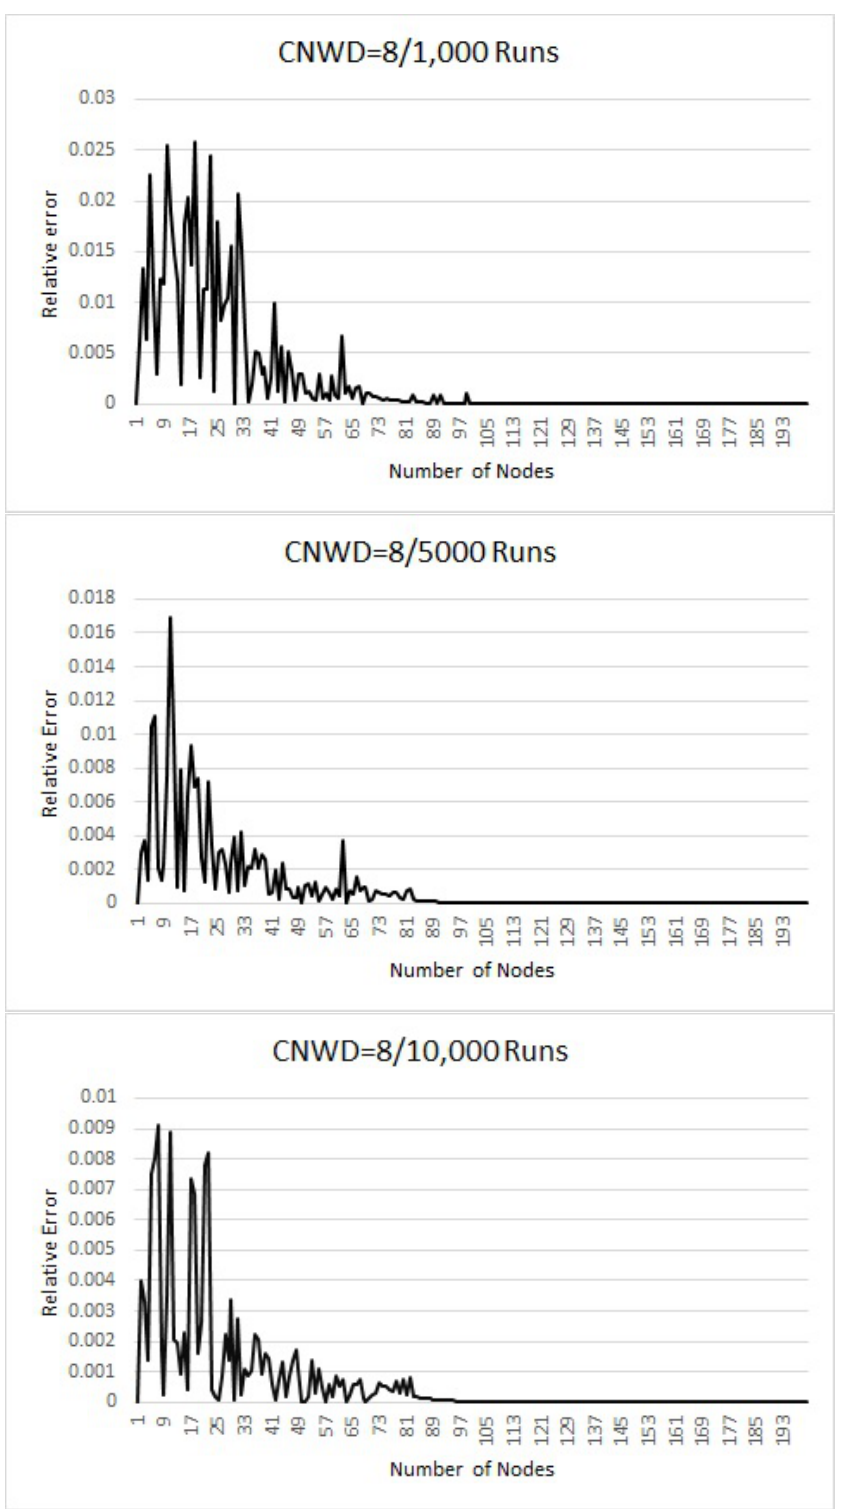
Figure 2. Theoretical vs. Simulated results for Contention Window ( CNWD ) =